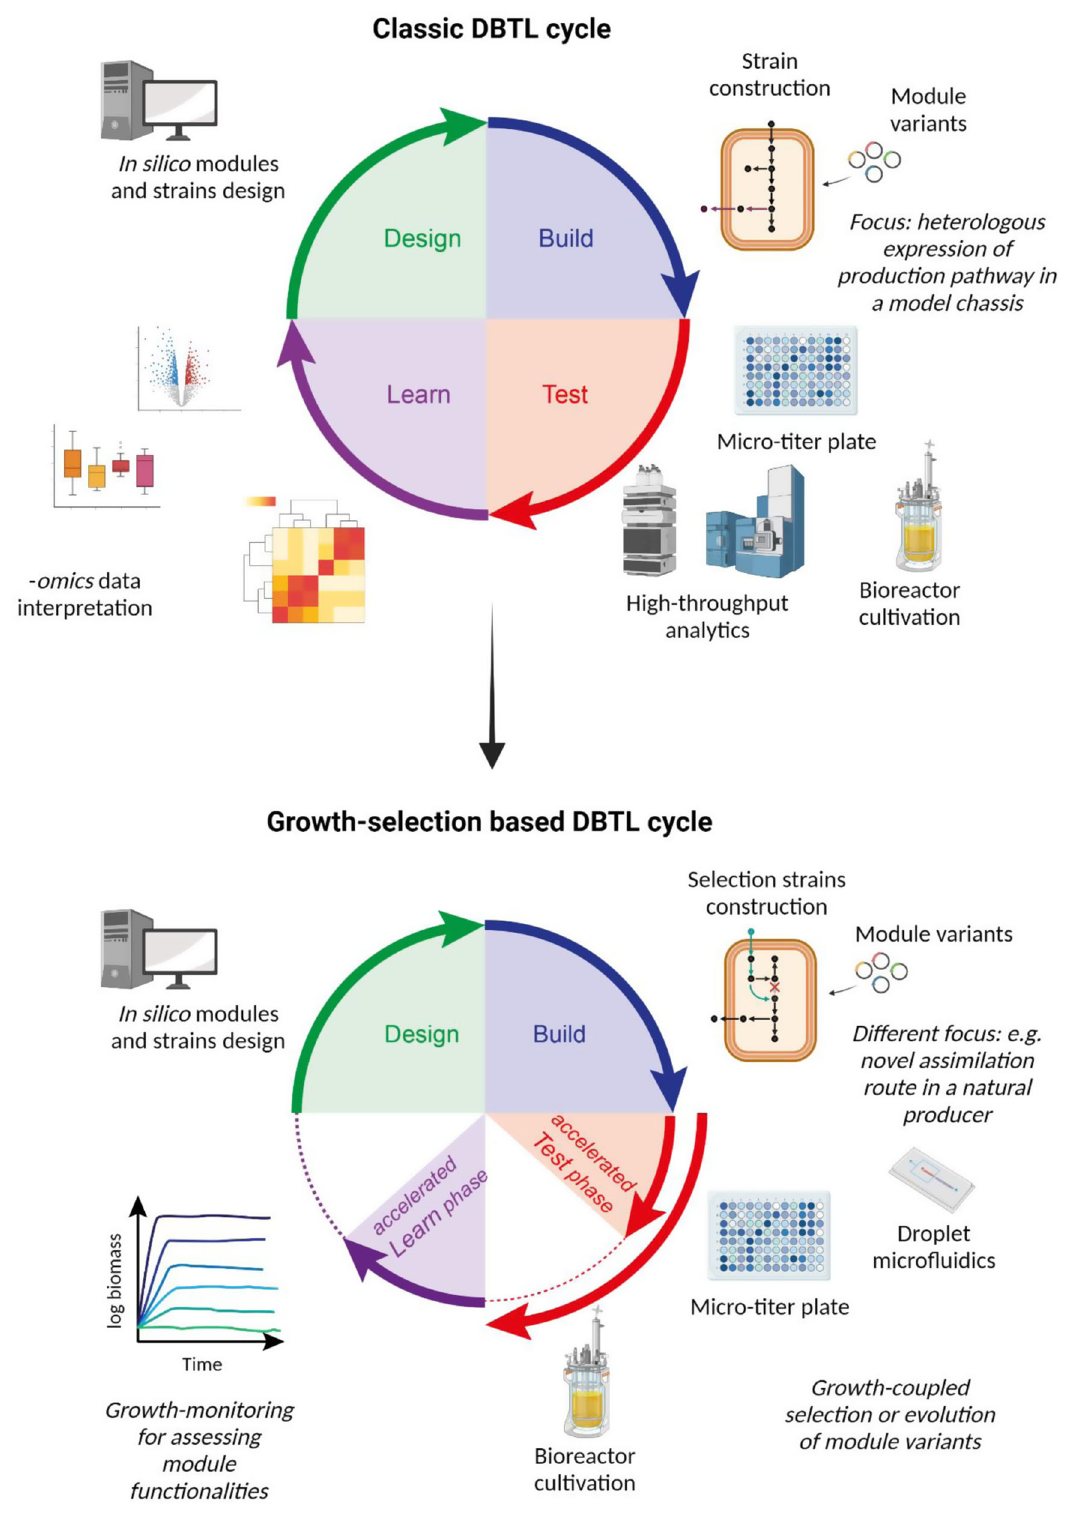
Fig. 2 The classical “ design-build-test-learn ” (DBTL) pipeline (top) compared to the “ growth selection-based ” DBTL cycle proposed in this study (bottom). The “ design ” and “ build ” phases are supported by the same technologies in both cycles. Nevertheless, the novel pipeline changes in the “ test ” and “ learn ” phases, which become faster in their execution due to the lack of - omics analyses (shorter red and purple arrows). In case of necessity, the new cycle can host adaptive laboratory evolution within its “ test ” phase (longer red arrow). Created with BioRender.com.